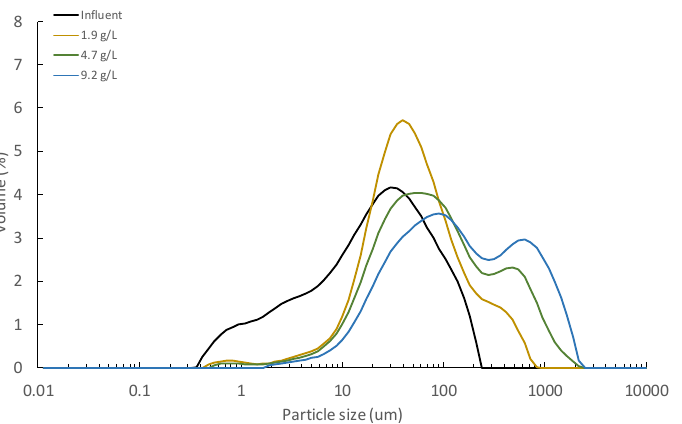
Figure 7. Particle size distribution of the concentrated sludge during the lab-scale operation. Note that legend shows the total suspended solids concentration fed to the lab-scale membrane which was obtained by concentrating the influent with an ultrafiltration membrane.